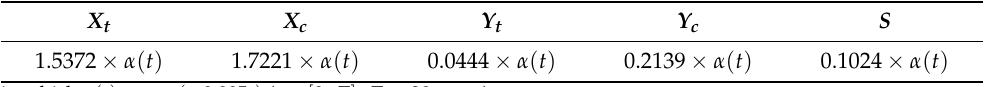
Table 3. Basic strength variables of the laminated composite plate (unit: GPa ). X t